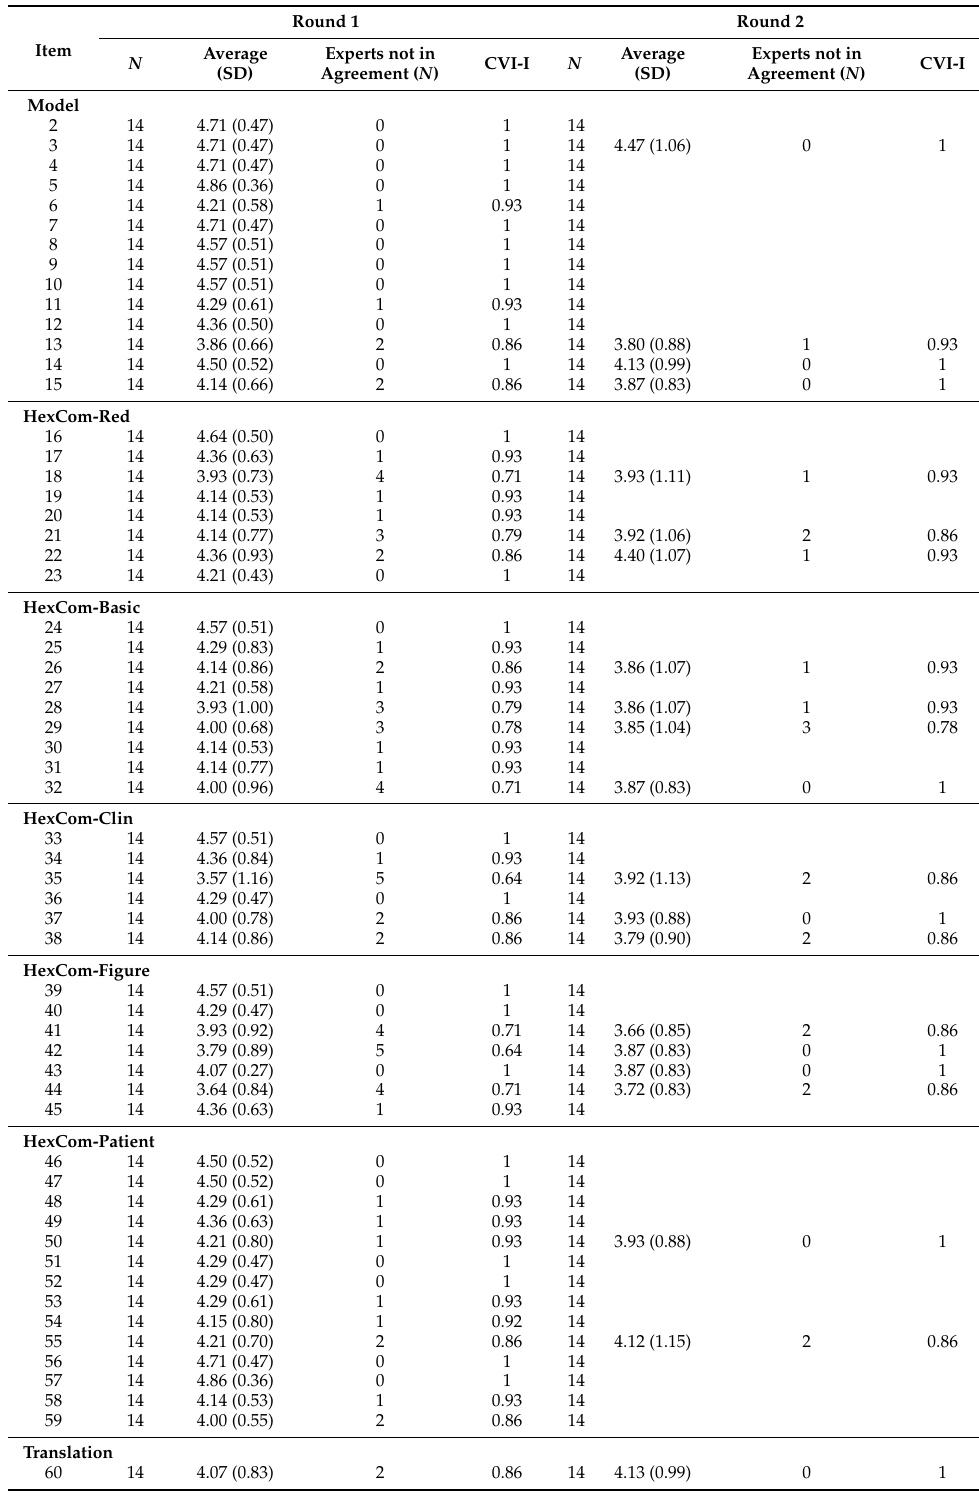
Table 4. Expert answers rounds 1 and 2, with average, standard deviation (SD), number of experts in disagreement, and the content validity by item index